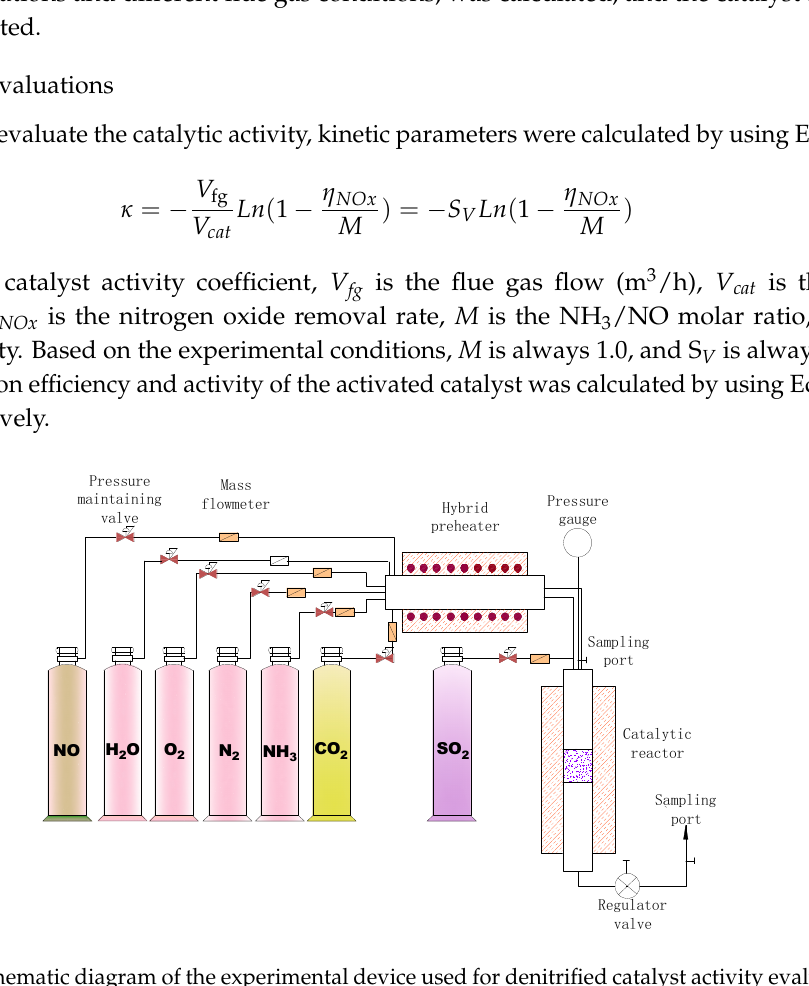
Figure 2. Schematic diagram of the experimental device used for denitrified catalyst activity evaluation.